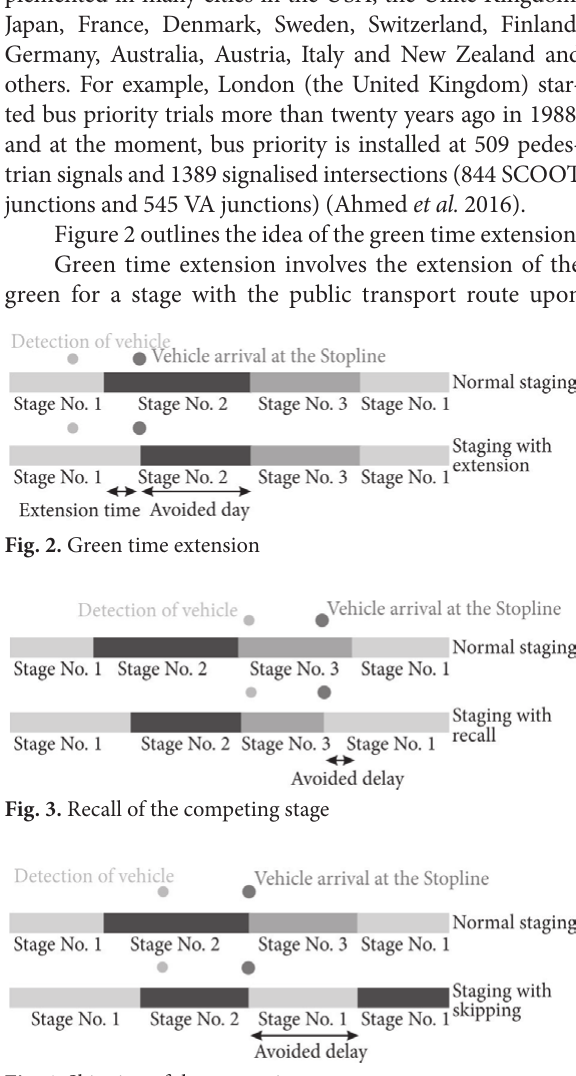
Fig. 4. Skipping of the competing